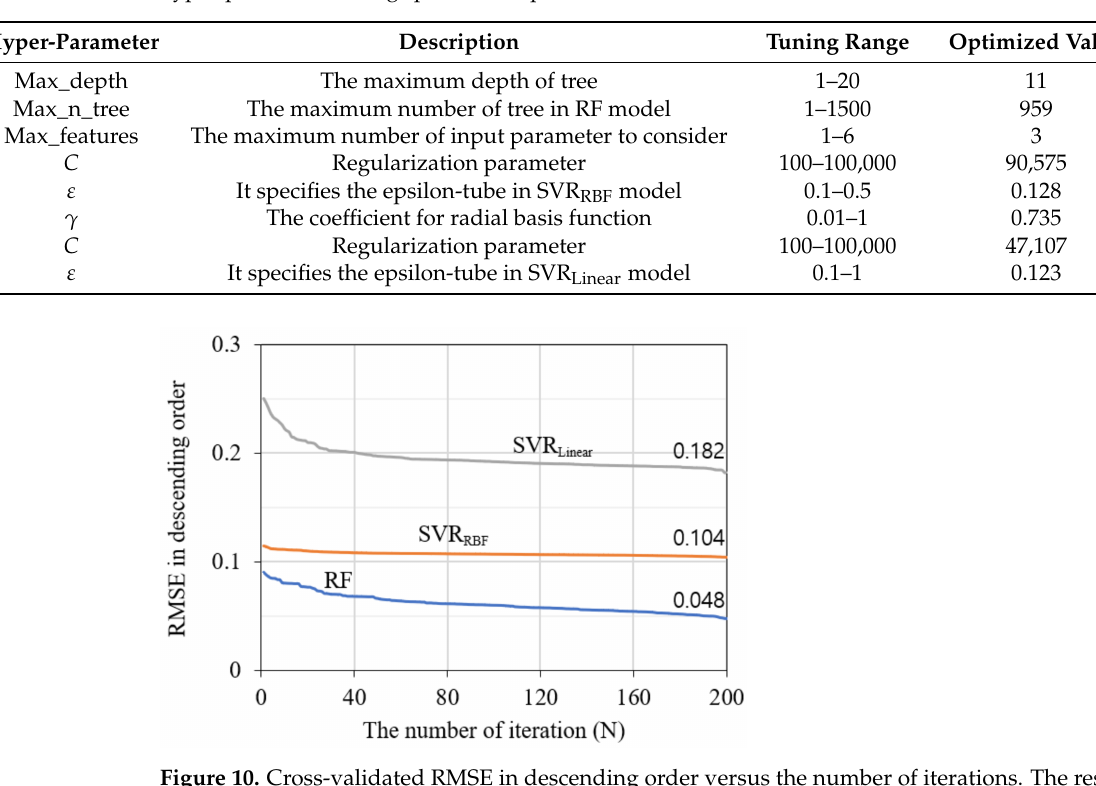
Table 4. Hyper-parameter tuning spaces and optimized values for each ML method.